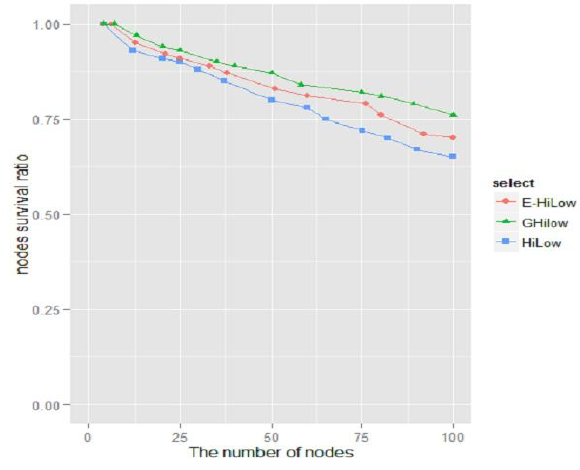
Figure 3. Nodes survival